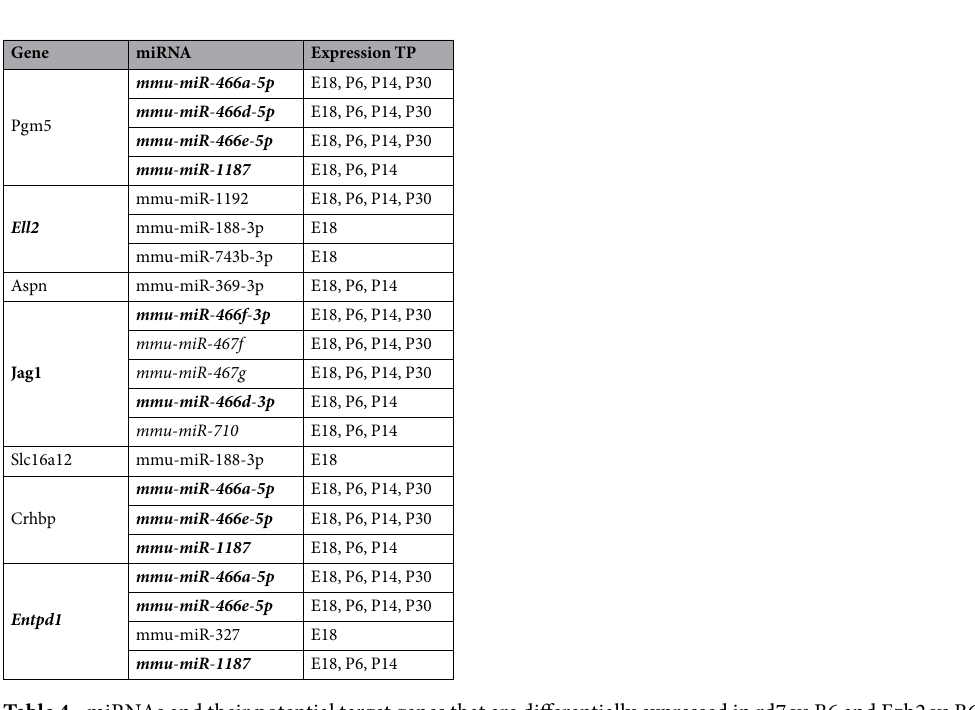
Table 4. miRNAs and their potential target genes that are differentially expressed in rd7 vs B6 and Ezh2 vs B6. Genes and miRNAs regulated by NR2E3 are in bold; genes and miRNAs regulated by RORA are in italics, and genes and miRNAs regulated by NR2E3 and RORA are bold and italics. Minimum 2 fold change and p <